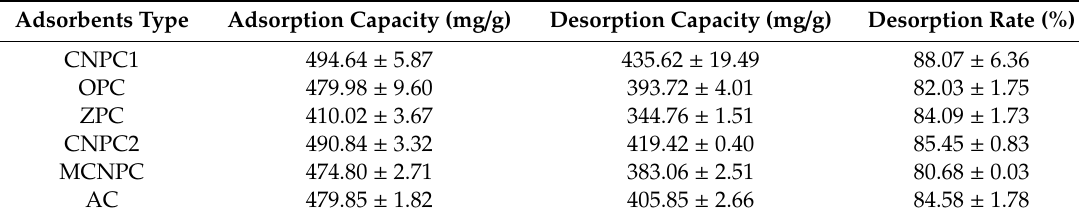
Table 1. The adsorption and desorption characteristics of total polymethoxyflavones on different adsorbents. Adsorbents